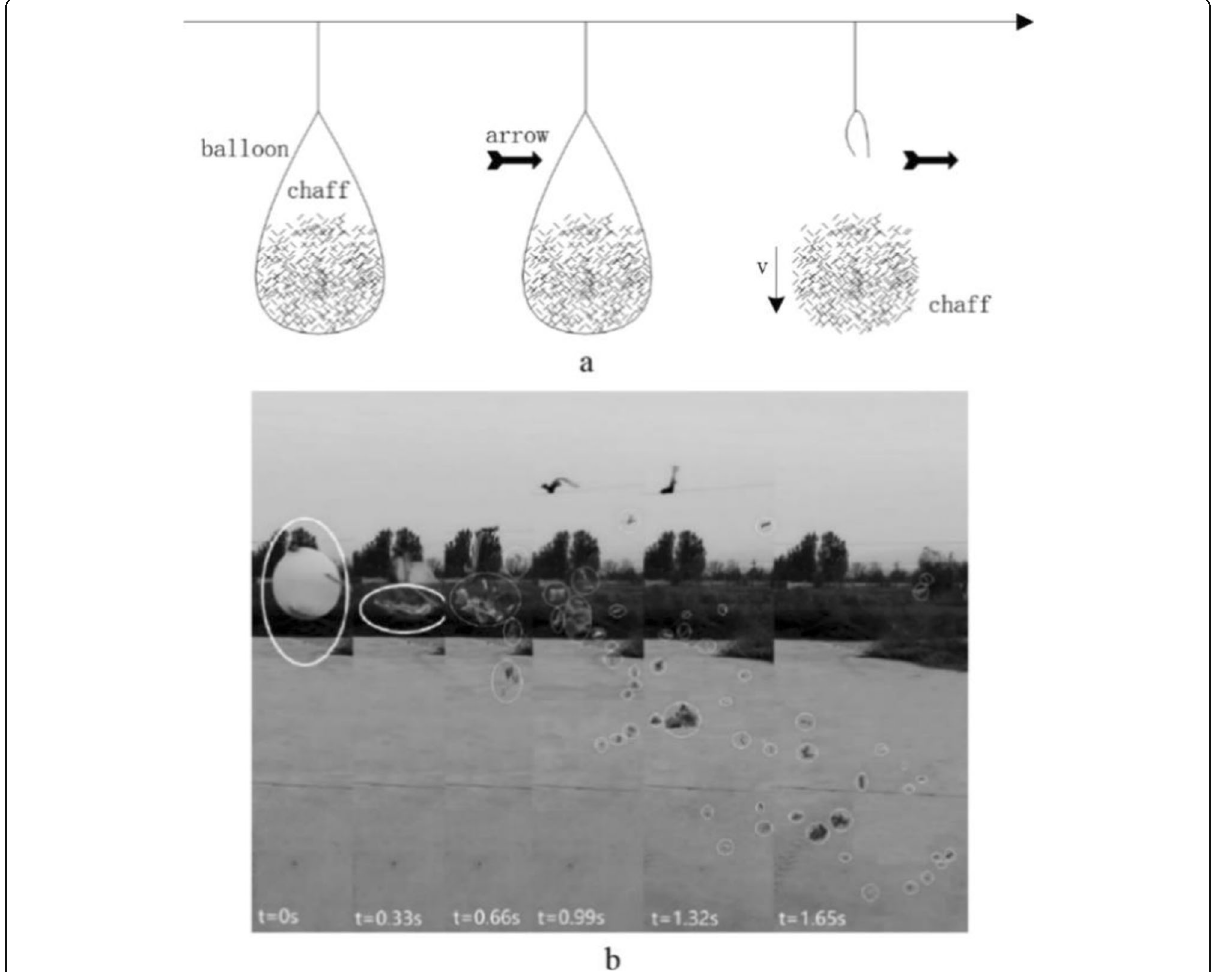
Fig. 12 Chaff dipole dispersion experiment: a chaff dipoles thrown from a balloon, and b the chaff dipole dispersion